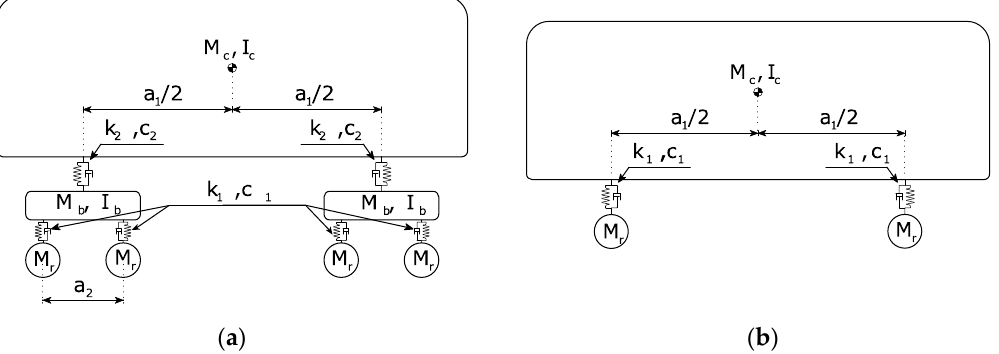
Figure 3. Dynamic models of the railway vehicle: ( a ) Alfa Pendular; ( b ) freight wagon. Table 2. Geometric and mechanical properties of the trains [40].